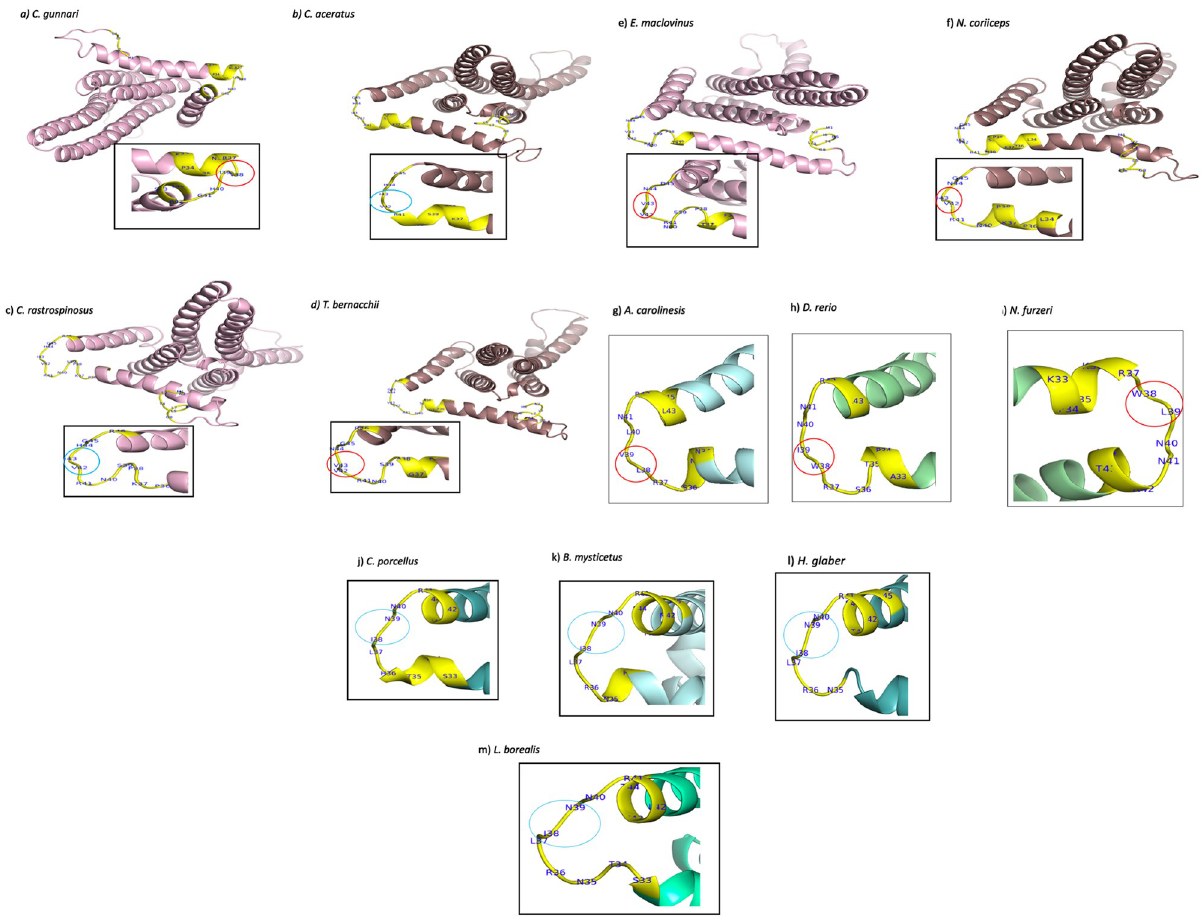
Fig 7. Representative structures of ATP synthase F 0 subunit 6 for the fourteen vertebrate species created using I-TASSER [41] suite and visualised and edited using PyMOL v. 2.3.2. a) C . gunnari (-/-) residues 38 (valine) and 39 (isoleucine) shows strand structure b) C . aceratus (-/-) residues 42(valine) and 43 coil (isoleucine), aligning with 38/39 in MSA, show a coil structure c) C . rastrospinosus (-/+) residues 42-Valine and 43-Isoleucine has a coil structure d) T . bernacchii (+/+) residues 42-Valine and 43-Valine show a strand structure e) E . maclovinus (+/+) residues 42 -Valine and 43-Valine show a strand structure f) N . coriiceps (+/+) residues 42 (Valine) 43 (isoleucine) has a coil structure. g) A . carolinesis residues 38 (Leucine) and 39(Valine) show a strand structure h) D . rerio residues 38 (tryptophan) and 39(Isoleucine) show a strand structure i) N . furzeri residues 38 (Tryptophan) and 39 (Leucine) show a strand structure. j) C . porcellus residues 38 (Isoleucine) and 39 (Asparagine) show a coil structure k) B . mysticetus residues 38 (Isoleucine) and 39 (Asparagine) show a coil structure. l) H . glaber residues 38 (Isoleucine) and 39 (Asparagine) show a coil structure—m) L . borealis residues 38 (Isoleucine) and 39 (Asparagine) show a coil structure.